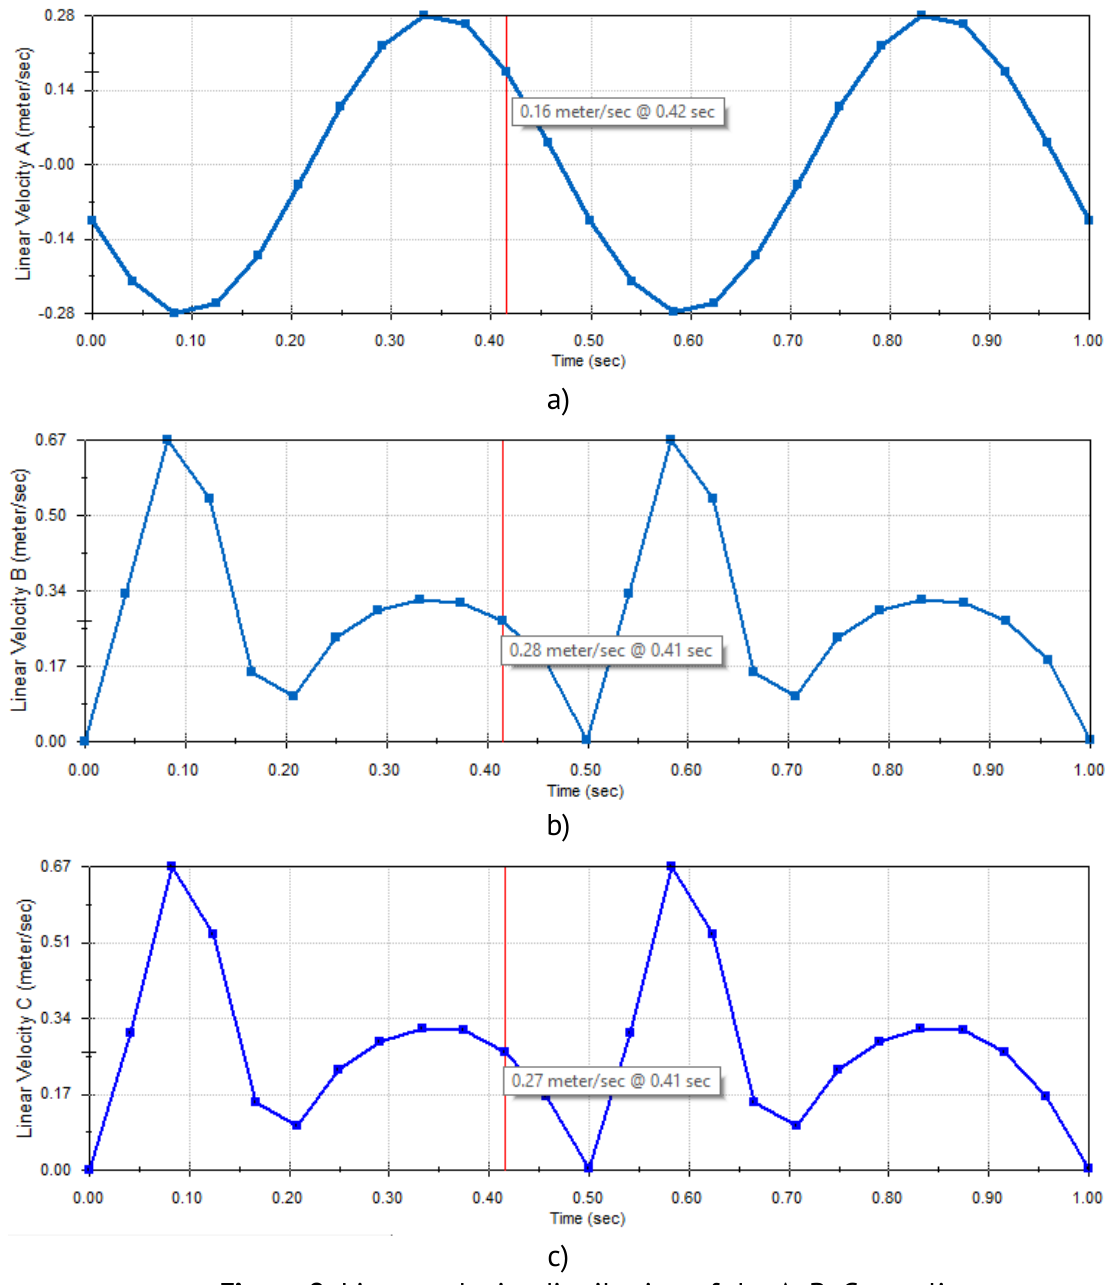
Figure 8. Linear velocity distribution of the A, B, C